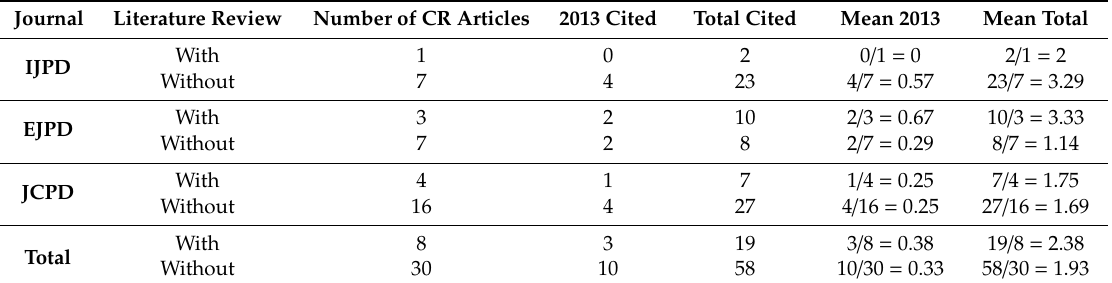
Table 4. Citations of RDP CRs published on major PD journals with or without literature